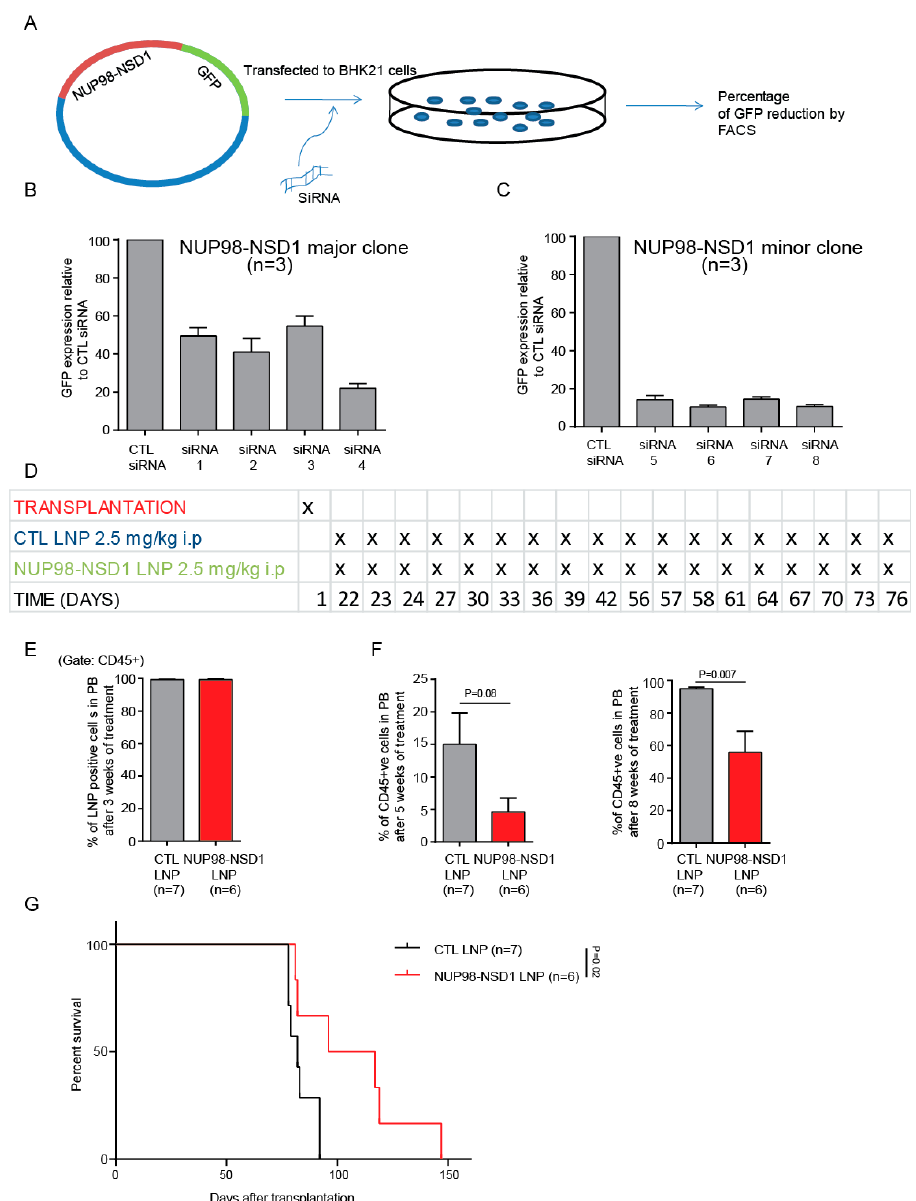
Figure 5. Treatment of the NUP98-NSD1 PDX model with NUP98-NSD1 siRNA-LNPs prolongs survival of mice. ( A ) Schematic presentation of the siRNA screening procedure. BHK21 cells were transfected with siRNAs and plasmid. Three days post-transfection, GFP expression was measured by flow cytometry. ( B ) Efficacy of four siRNAs against the major clone of NUP98-NSD1 (mean ± SEM). The CTL siRNA was directed against BCR-ABL, which is not expressed in the studied cells. ( C ) Efficacy of 4 siRNAs against the minor clone of NUP98-NSD1 (mean ± SEM). The CTL siRNA was directed against BCR-ABL, which is not expressed in the studied cells. ( D ) Schematic outline of the LNP-siRNA treatment schedule in the NUP98-NSD1 PDX model. The LNP-siRNA treatment was started 3 weeks after transplantation of NUP98-NSD1 PDX cells and was applied in 2 cycles of 3 weeks each. Control and NUP98-NSD1 siRNA formulations were injected ad day 1, 2, and 3 and then every 3rd day in each cycle with a dose of 2.5 mg / kg. ( E ) LNP uptake in CD45 + AML cells in peripheral blood of treated mice after 3 weeks of treatment. ( F ) Engraftment of human CD45-positive AML cells at 8 and 11 weeks of transplantation (after 5 and 8 weeks of treatment) in peripheral blood of NUP98-NSD1 AML PDX mice treated with control or NUP98-NSD1 siRNA / LNP formulations (mean ± SEM). ( G ) Survival of NUP98-NSD1 AML-PDX mice treated with LNP-siRNA (CTRL or